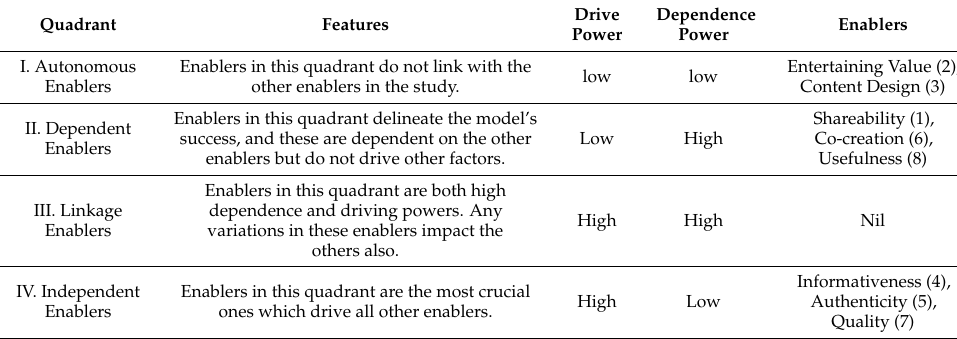
Table 7. Quadrants of the Fuzzy MICMAC